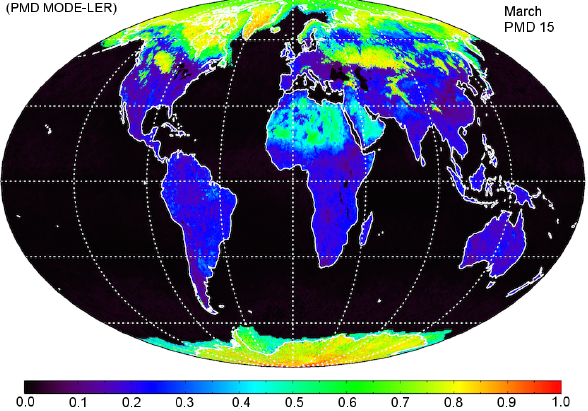
Figure 19. Example of the GOME-2 surface LER determined from PMD band 15 (centred around 799nm) for March. The snow cover on northern latitudes as well as the Sahara are clearly seen.